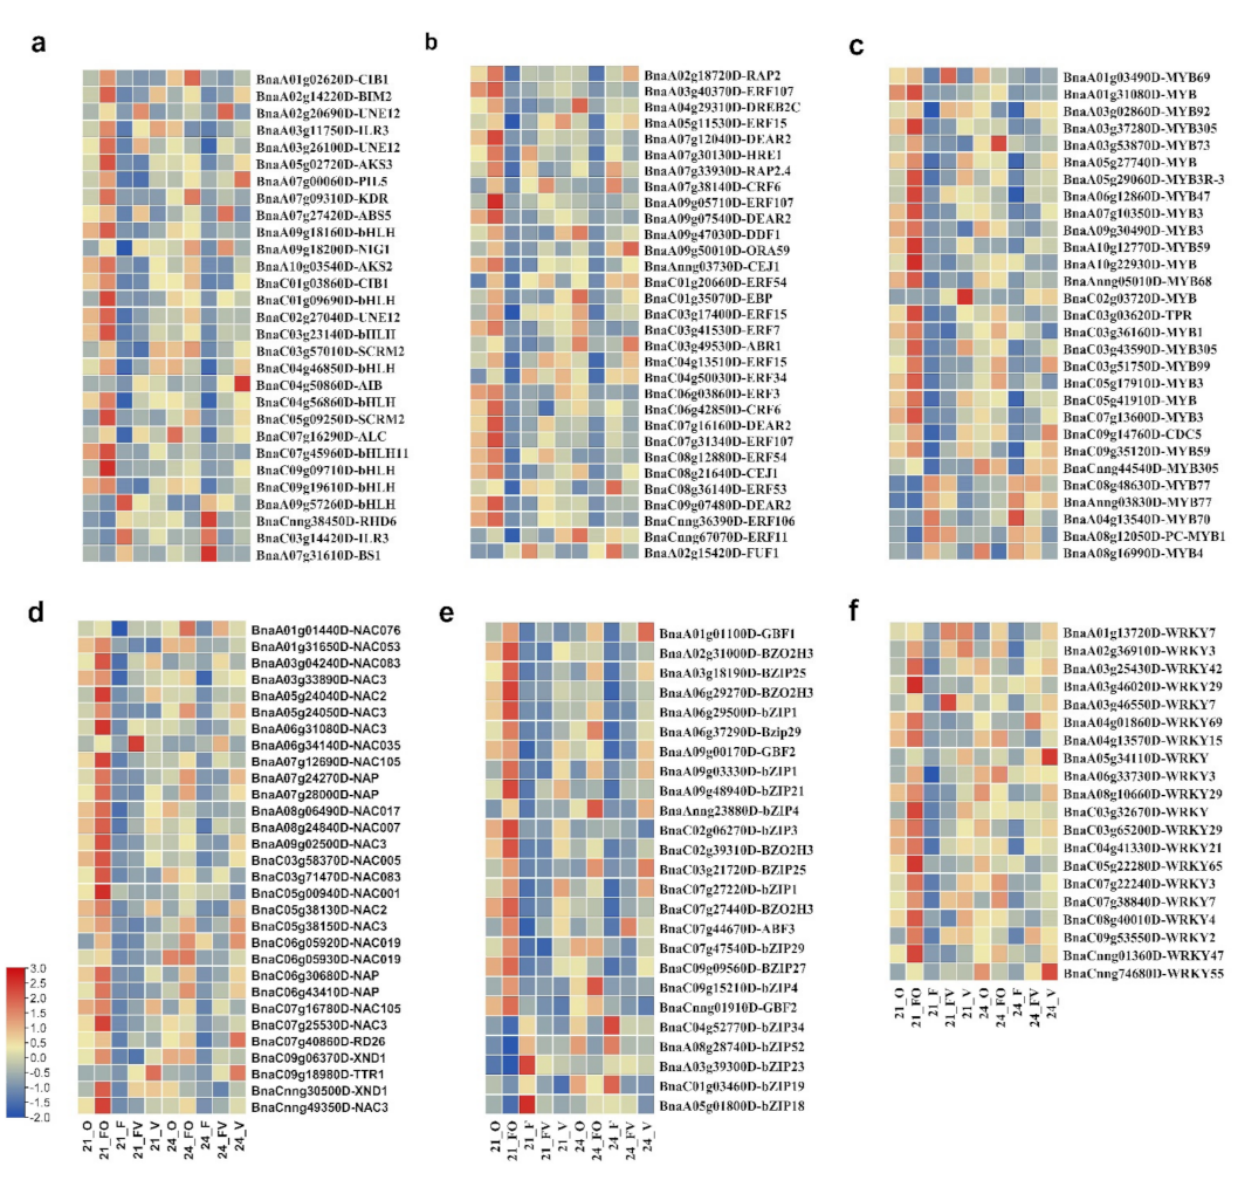
Figure 7. A heatmap illustrating the samples centralized by change expression patterns of differentially expressed tran- scription factors (TFs) in hybrids (FO and FV) and their parents (O, F, and V). All the TFs were cross − checked with the plant TF database. ( a ) bHLH, ( b ) ERF, ( c ) MYB, ( d ) NAC, ( e ) bZIP, and ( f ) WRKY. The expression profiles of DEGs shown in heatmaps according to counts of the normalized feature (log2 (1 + counts)) using the red depth color representing the expression of up − regulated genes and blue representing the expression of down-regulated genes. T1: 21 days after sowing (DAS); T2: 24